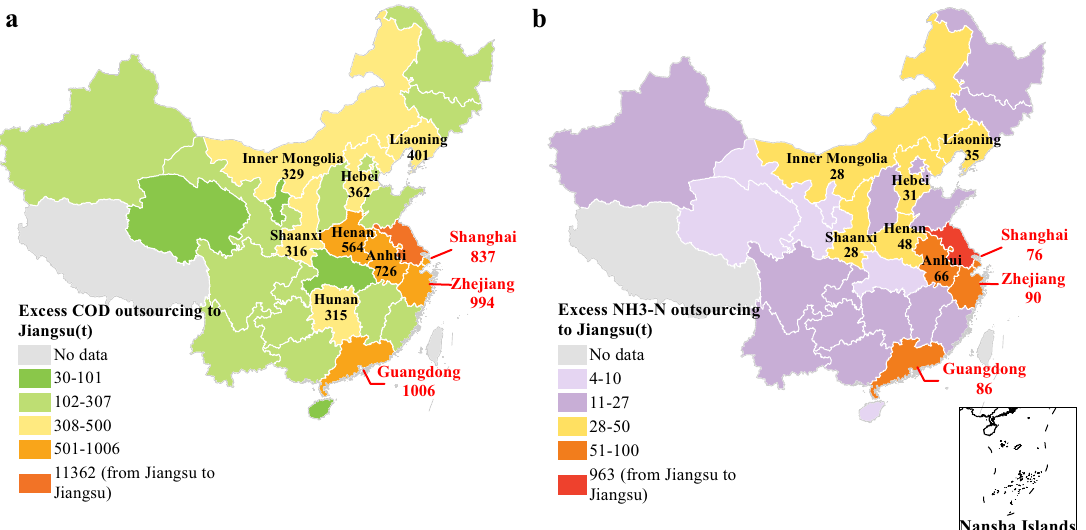
Fig. 3 Excess pollution discharge in Jiangsu induced by fi nal demand of Jiangsu and other Chinese provinces. a Excess COD and b excess NH 3 -N. Map colours show the amount of excess pollution embodied in the exported products of Jiangsu to 30 Chinese provinces (tons/yr). The top 10 provinces outsourcing excess pollution to Jiangsu are marked on the map.